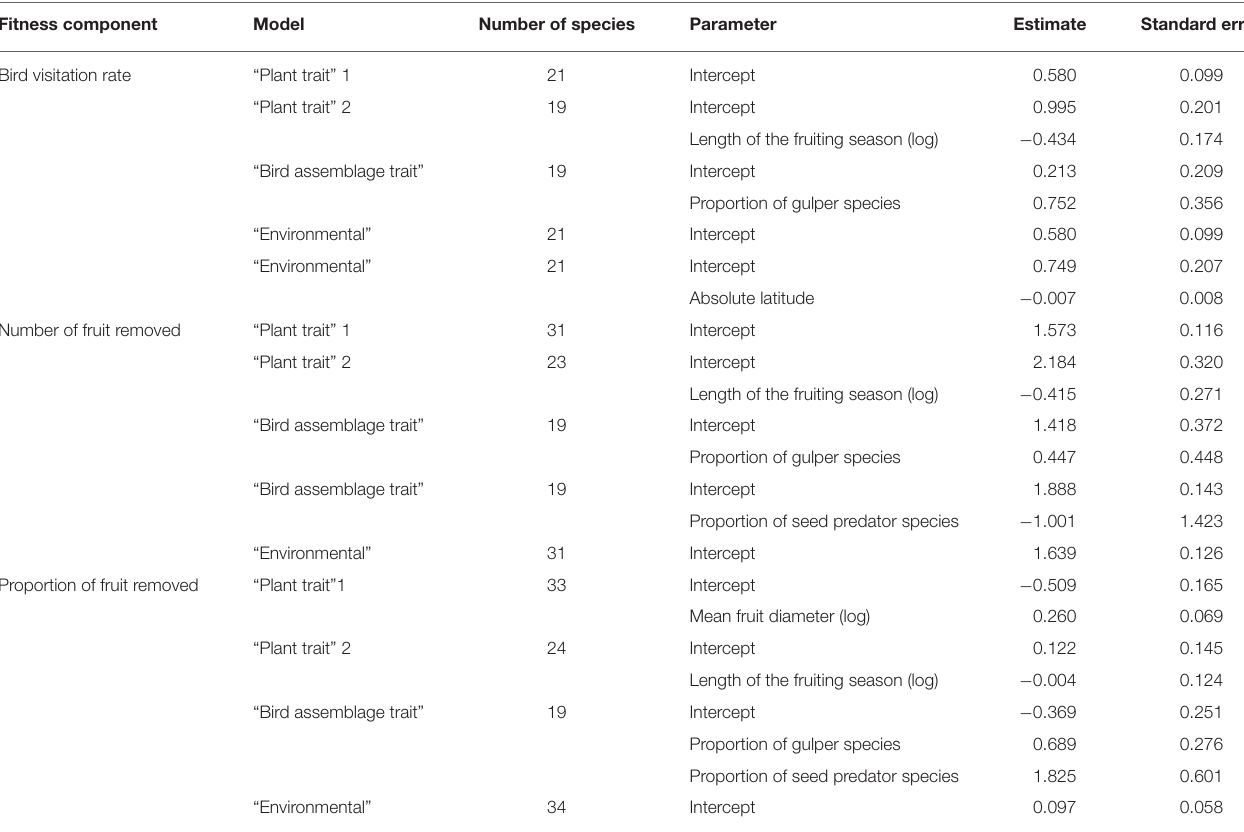
TABLE 3 | Effects of explanatory variables on bird-mediated selection on fruit crop size. Fitness